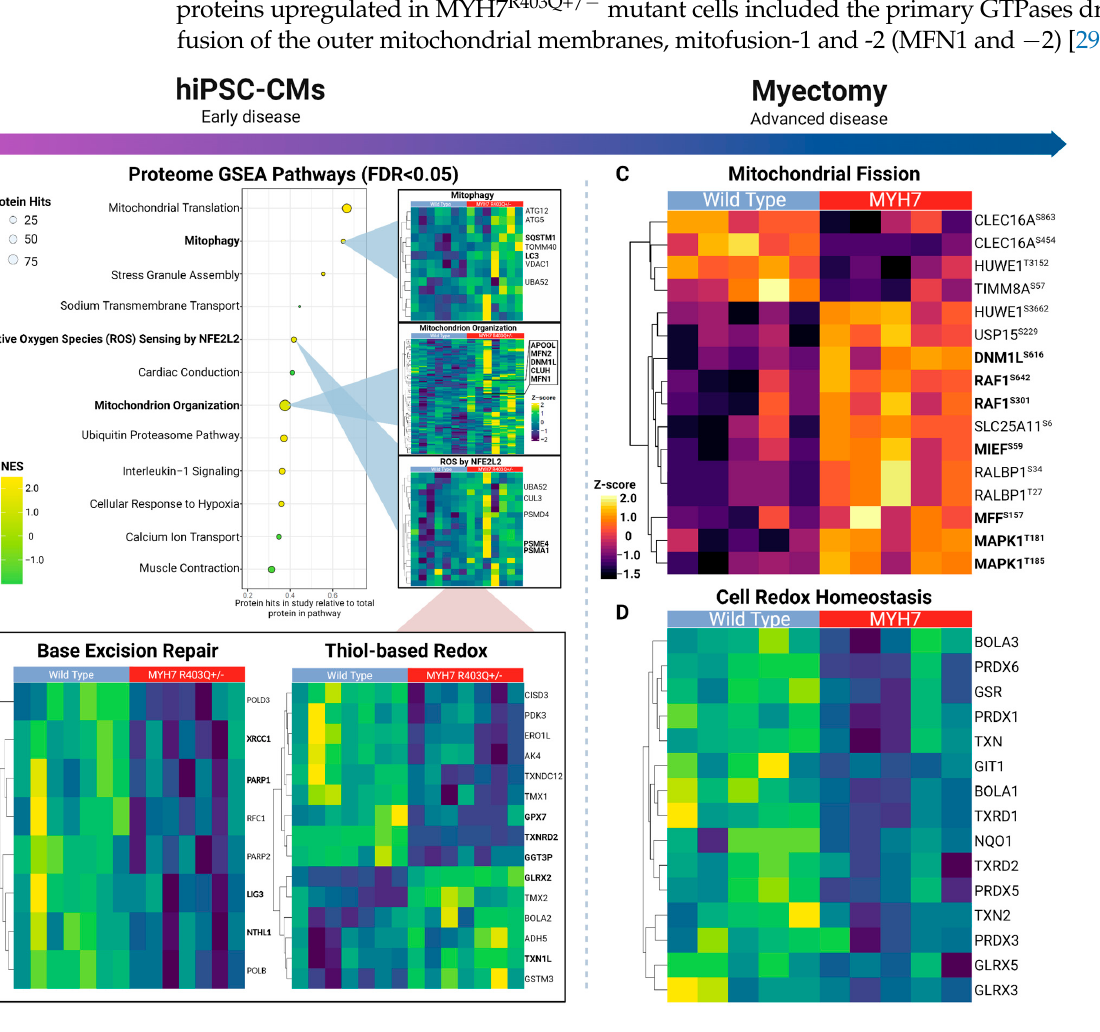
Figure 3. Mitochondrial dynamics across early and advanced specimens. ( A ) Top differential path- ways from gene set enrichment analysis of mutant versus control hiPSC-CM proteome (left) with select heatmaps (right) showing hierarchically clustered (Euclidean distance) profiles of corre- sponding annotated protein components. ( B ) Depiction of base excision repair and glutathione- based redox proteins quantified in hiPSC-derived cardiomyocytes. ( C ) Mitochondrial fission-re- lated phosphosites quantified in myectomy specimens. ( D ) Thiol-based antioxidant response en- riched according to the affected patient proteome samples.